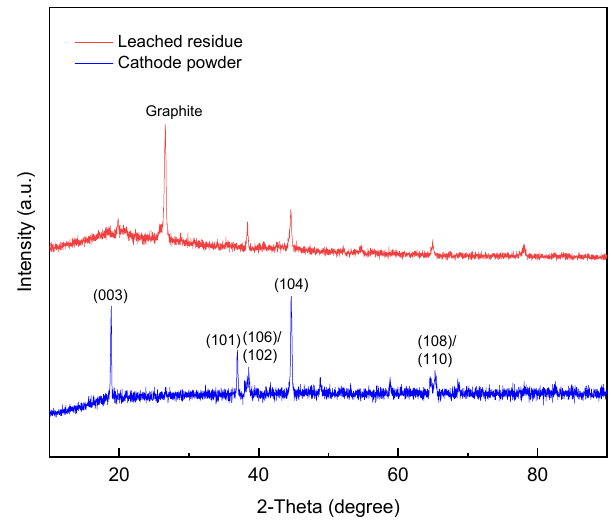
Figure 5. XRD patterns of recovered cathode powder and leached residue.